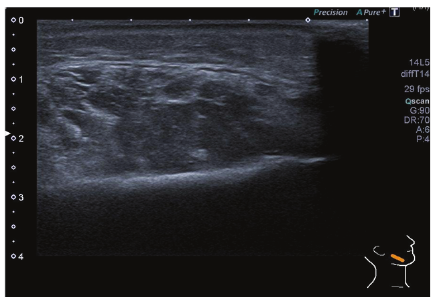
Figure 1: Ultrasound scan of the face shows a subcutaneous haematoma around the right masseter muscle measuring 2 cm in depth. No other pathology was